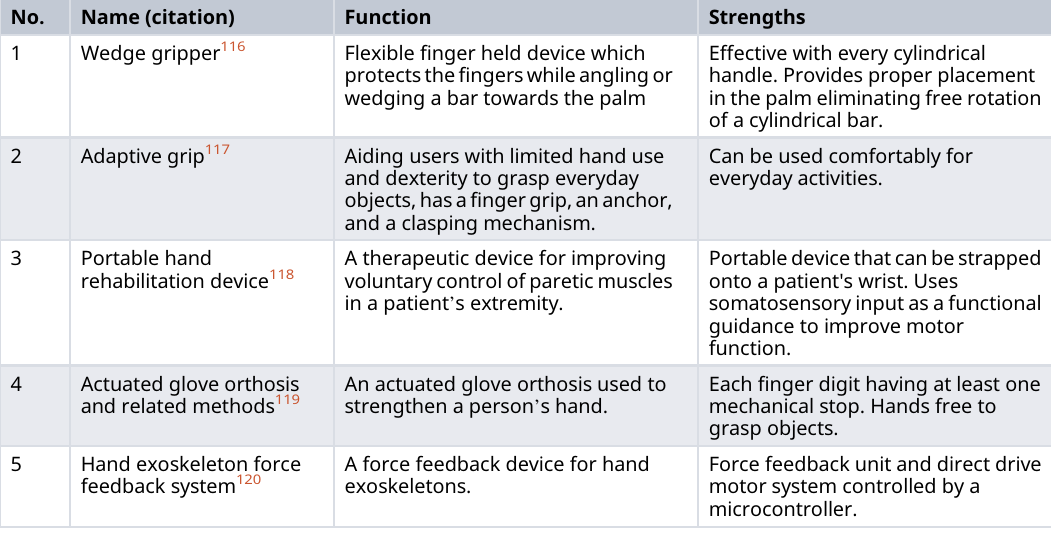
Table 5. Patents related to the pinch enhancer or any of its subfunctions.